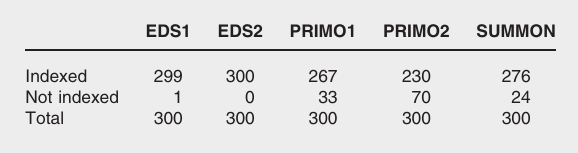
Web-scale discovery coverage of 300 MEDLINE citations